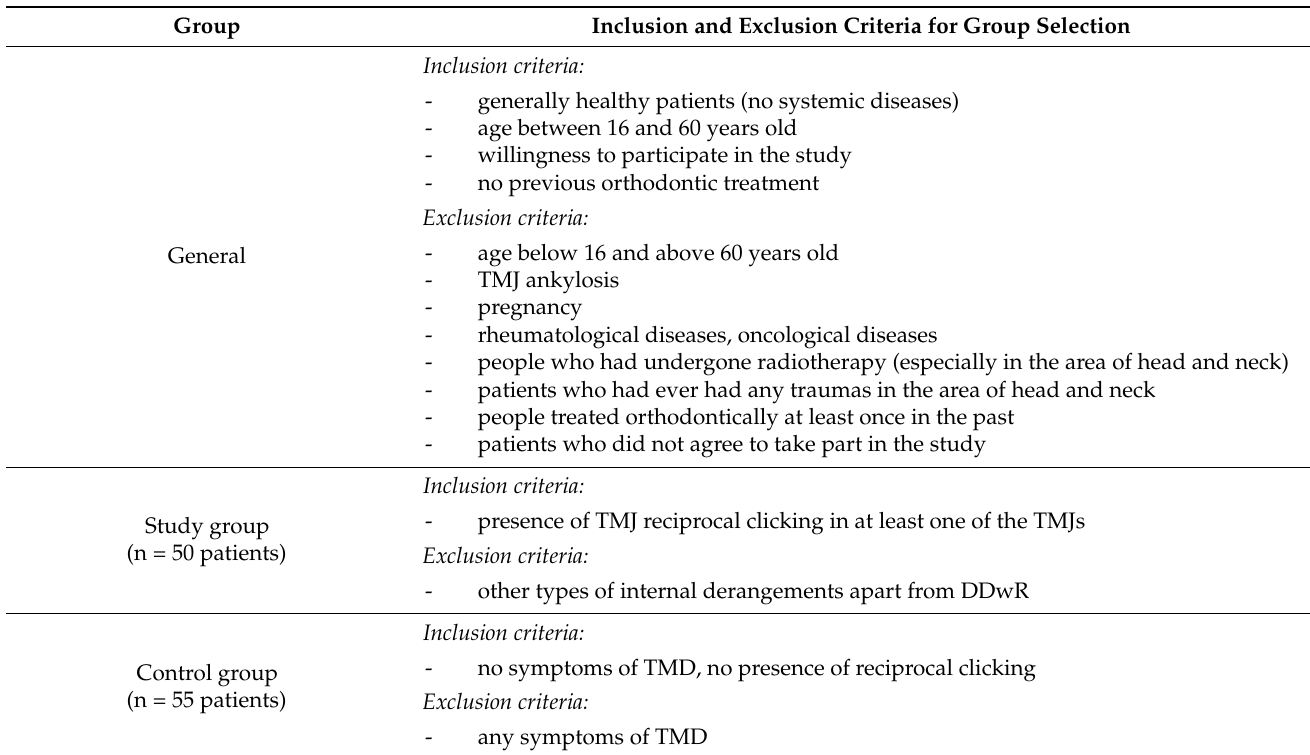
Table 1. Inclusion and exclusion criteria for both groups (study group and control group).